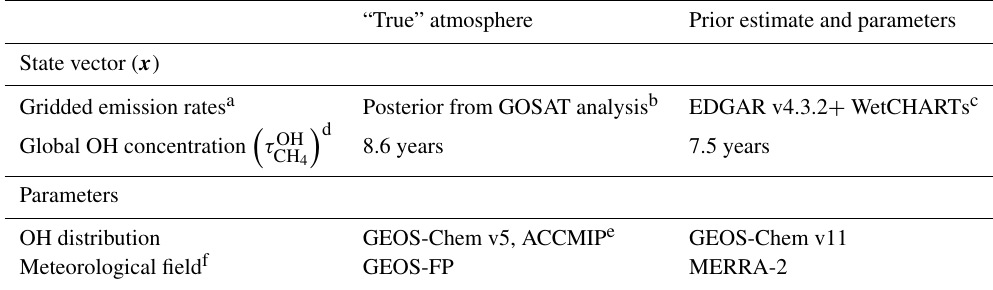
Table 1. OSSE conditions.